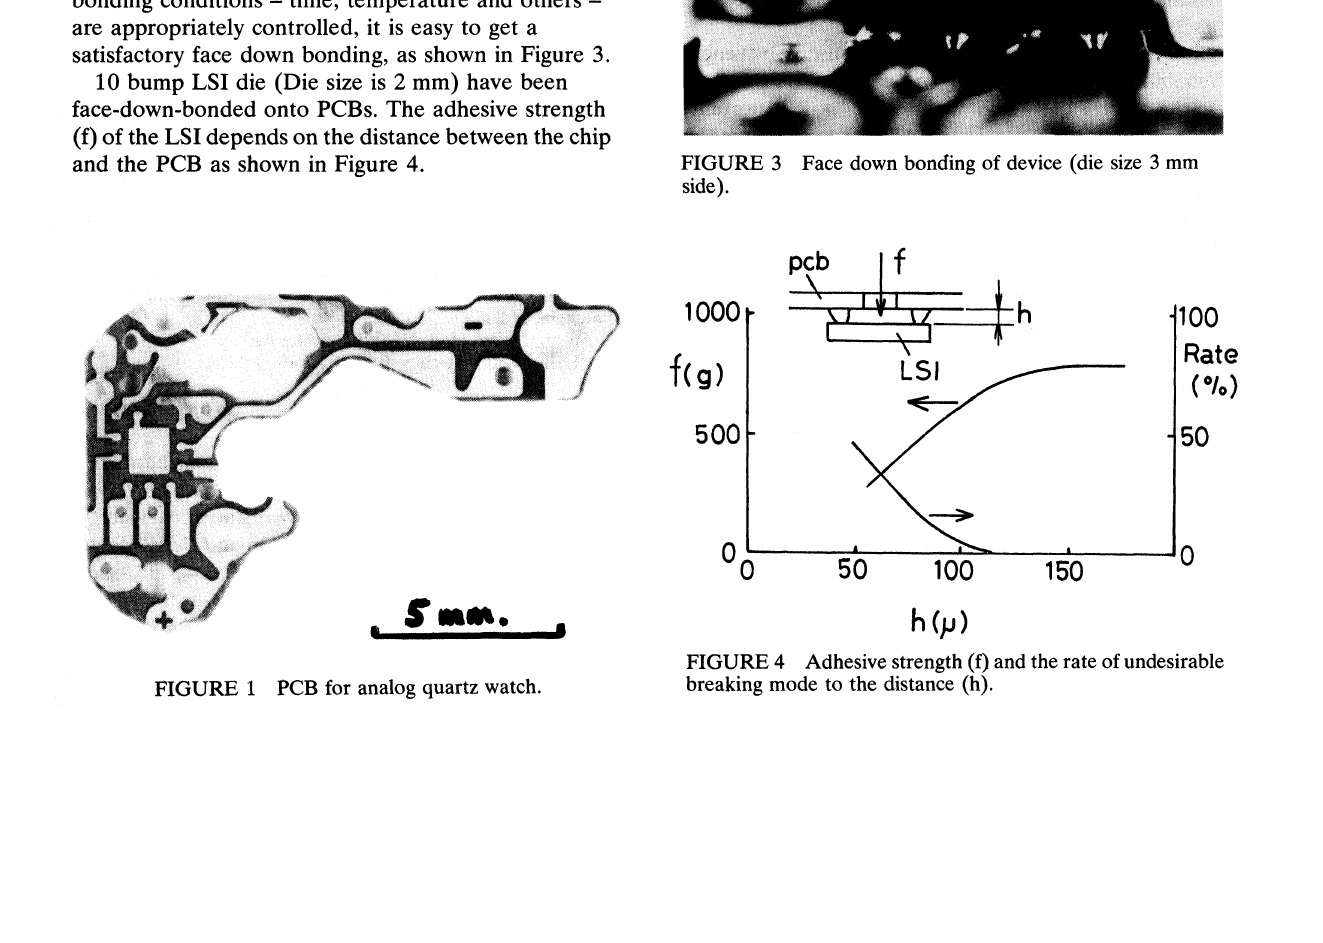
FIGURE 3 Face down bonding of device (die size 3 mm side).